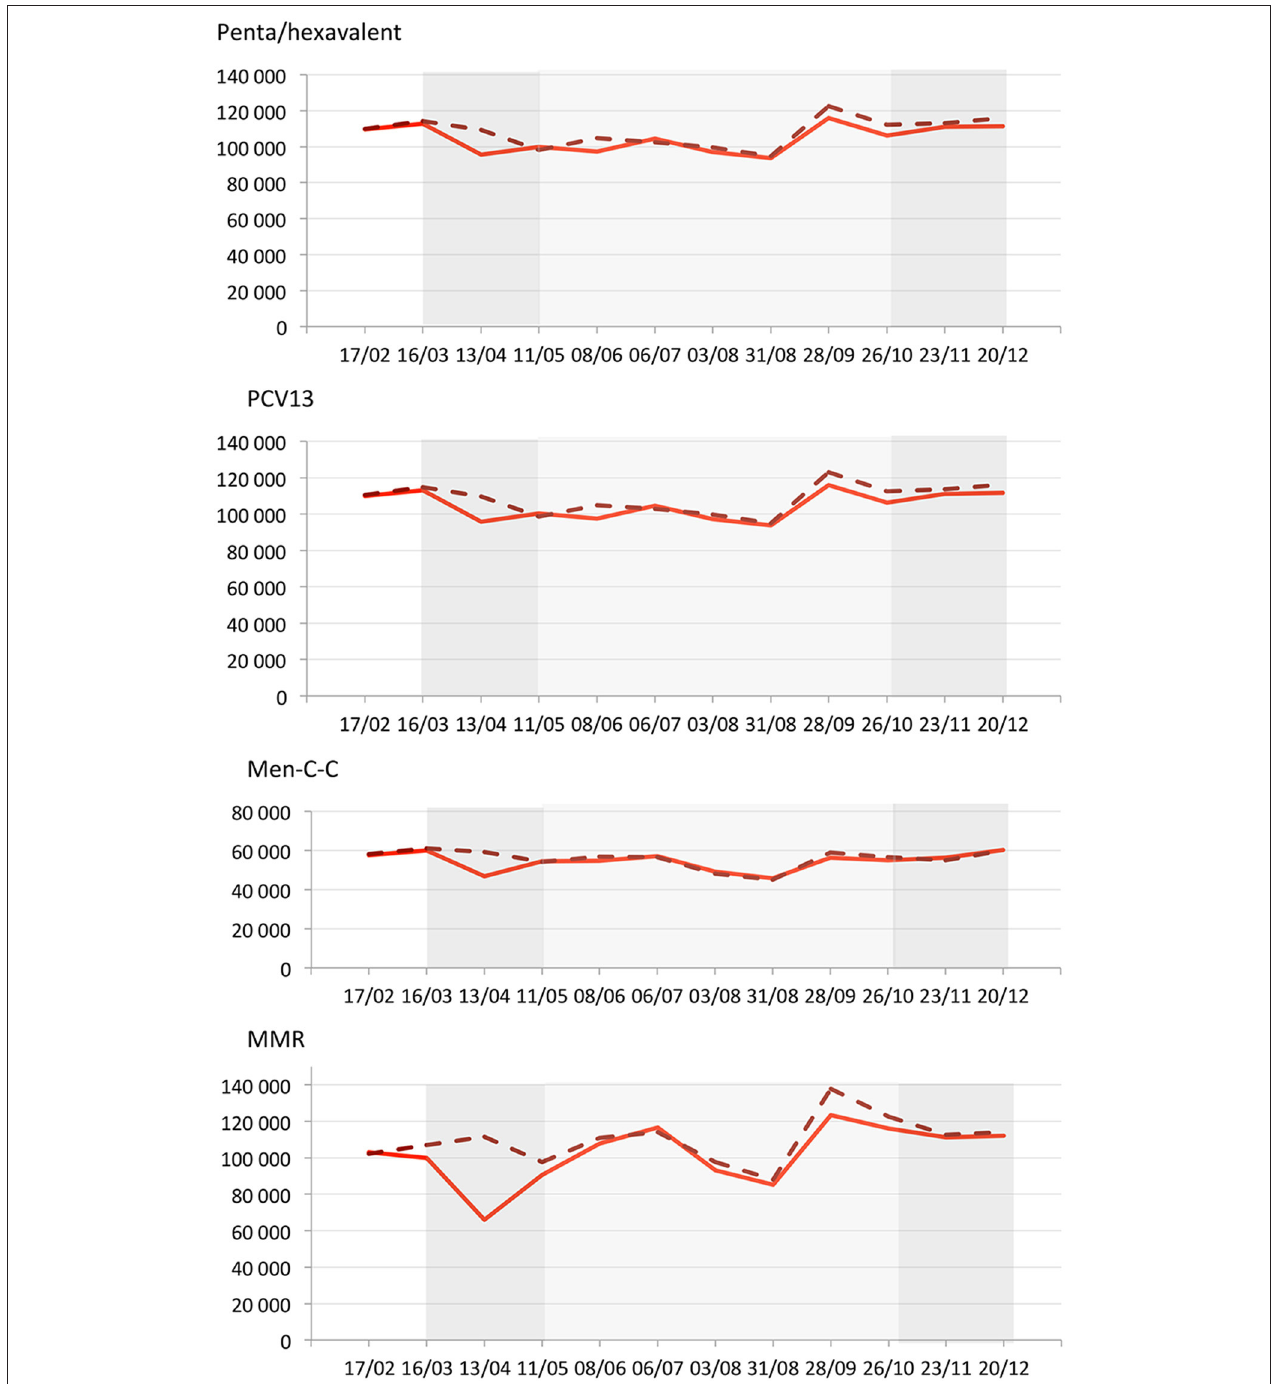
FIGURE 1 | Observed (solid red line) and expected (dashed red line) weekly counts for priming dose dispensations of penta/hexavalent, 13-valent-pneumococcal conjugate (PCV13), meningococcal-conjugate type-C (Men-C-C) and measles mumps rubella (MMR) in France (from January to December 2020). Dark gray rectangles illustrate the first and the second lockdowns (from 16/03 to 10/05 and from 30/10 to 15/12, respectively). Light gray rectangle illustrates the inter-lockdown period (11/05 to 29/10). The X-axis is in 4-week periods since the beginning of 2020. The Y axis represents the number of dispensed priming doses over the 4 previous weeks at each time